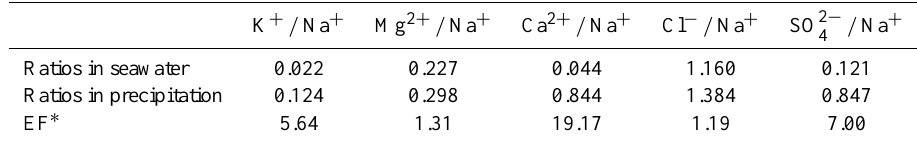
Table 3. Enrichment factors of major ions in precipitation at Uljin relative to seawater.